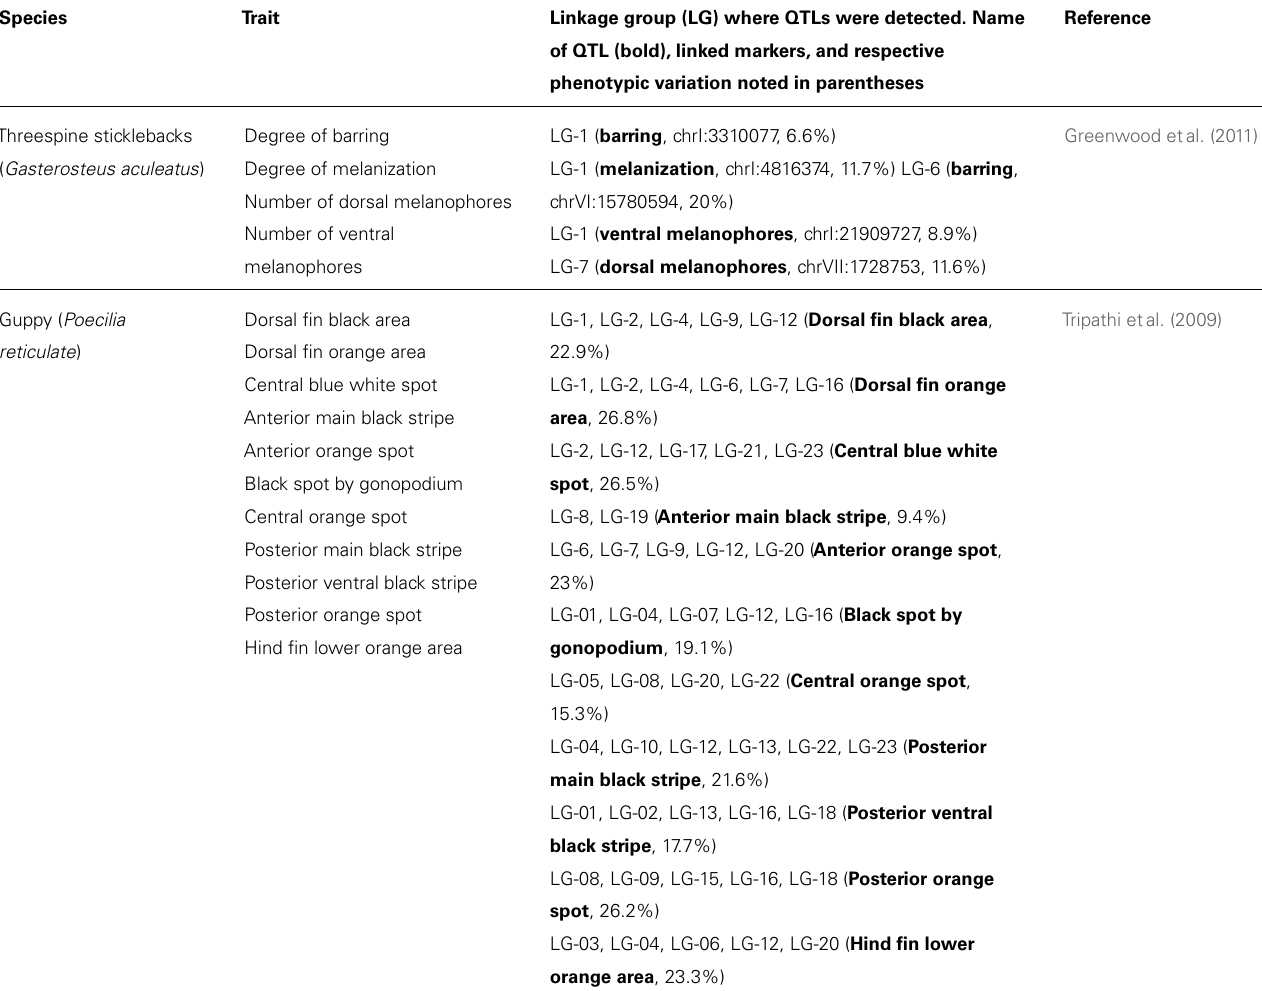
Table 3 | Examples of QTLs for skin pigmentation traits mapped on different fish model genomes. Species Trait Linkage group (LG) where QTLs were detected. Name of QTL (bold), linked markers, and respective phenotypic variation noted in parentheses